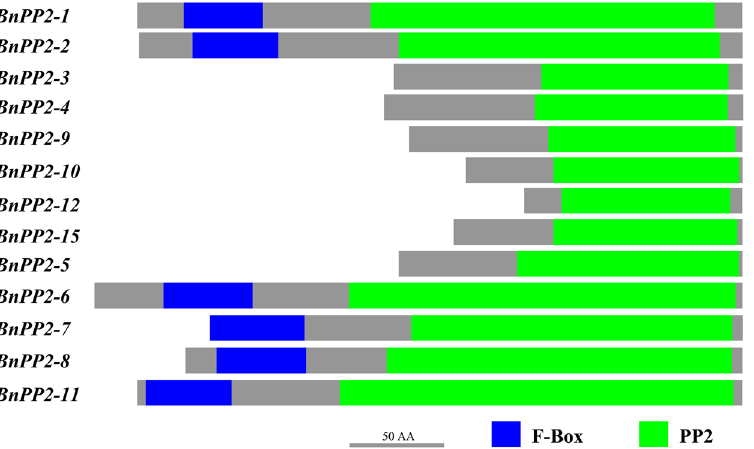
Figure 2. Schematic diagram of conserved domains in BnPP2 proteins. The green and blue blocks represented the PP2 domain and the F-BOX, respectively. Bar = 50 amino